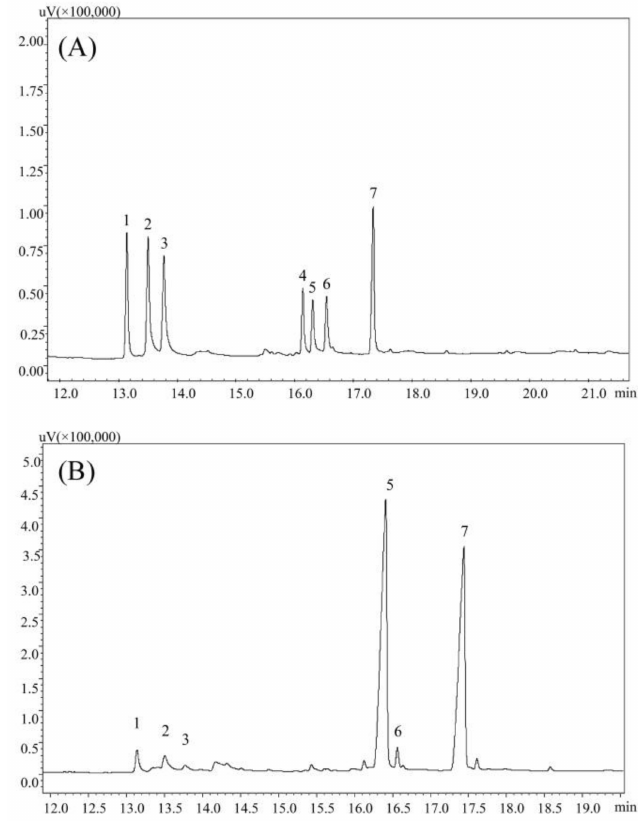
Figure 2. GC chromatograms of alditol acetate derivatives of standard monosaccharide ( A ) and PPs ( B ). Peak identity: 1-rhamnose, 2-arabinose, 3-xylose, 4-mannose, 5-glucose, 6-galactose, 7-internal standard